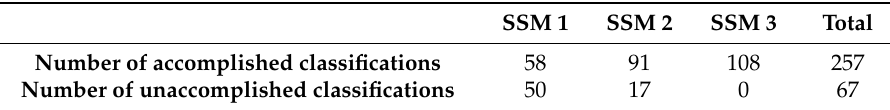
Table 6. Number of random forest